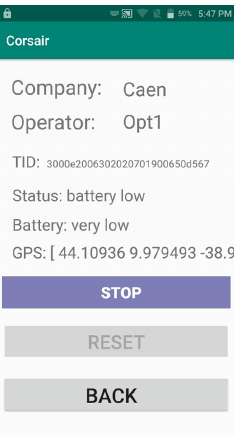
Figure 11. CORSAIR App screen that shows information about sensor node and allows the user to control